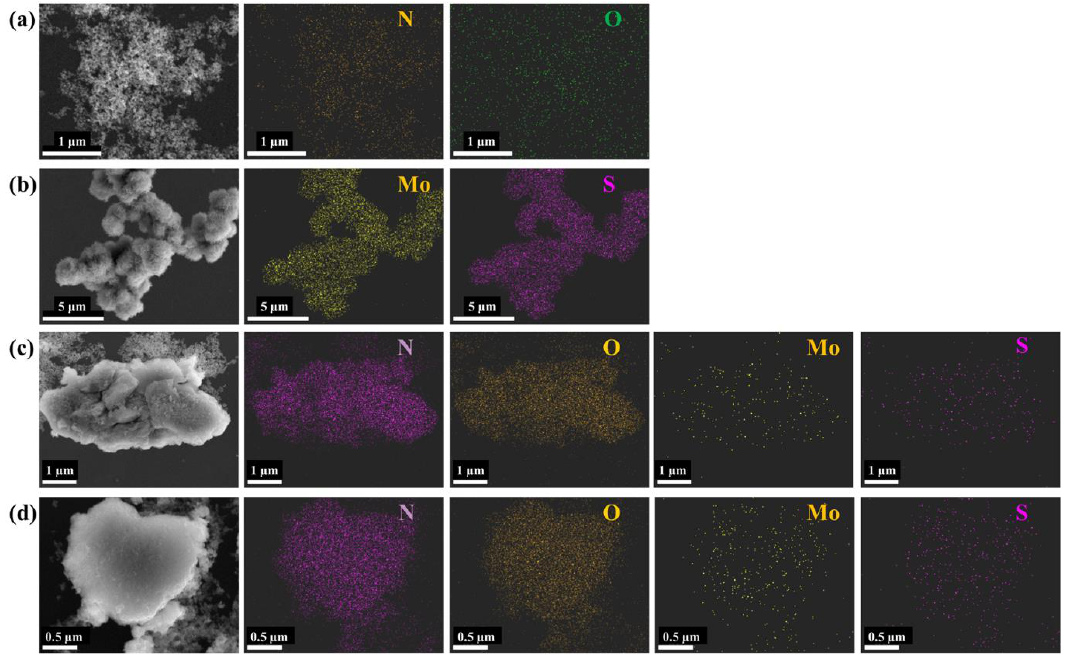
Figure 4. EDX elemental mapping of ( a ) N, ( b ) M, ( c ) NM3, and ( d ) NM10 composite nanoparticles.